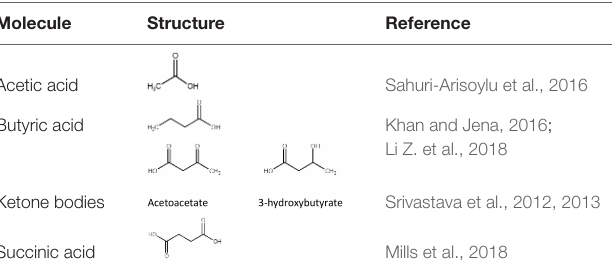
TABLE 1 | Some diet-derived small molecules known to activate brown fat and/or browning.